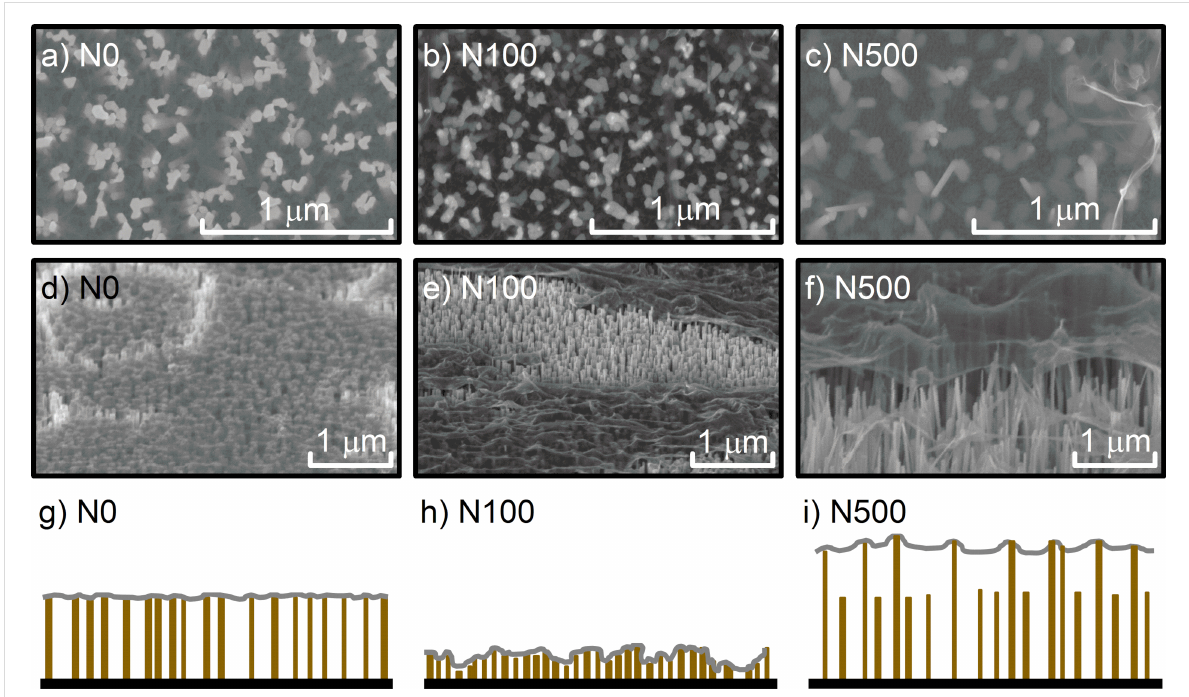
Figure 1: SEM images of graphene on GaN NWs with different variations in height in N0 (a,d), N100 (b,e), and N500 (c,f) samples. Images (a–c) were obtained at a 70° tilt of the sample while images (d–f) were collected in the plan view. The schematic profiles of the investigated samples are shown in (g–i).